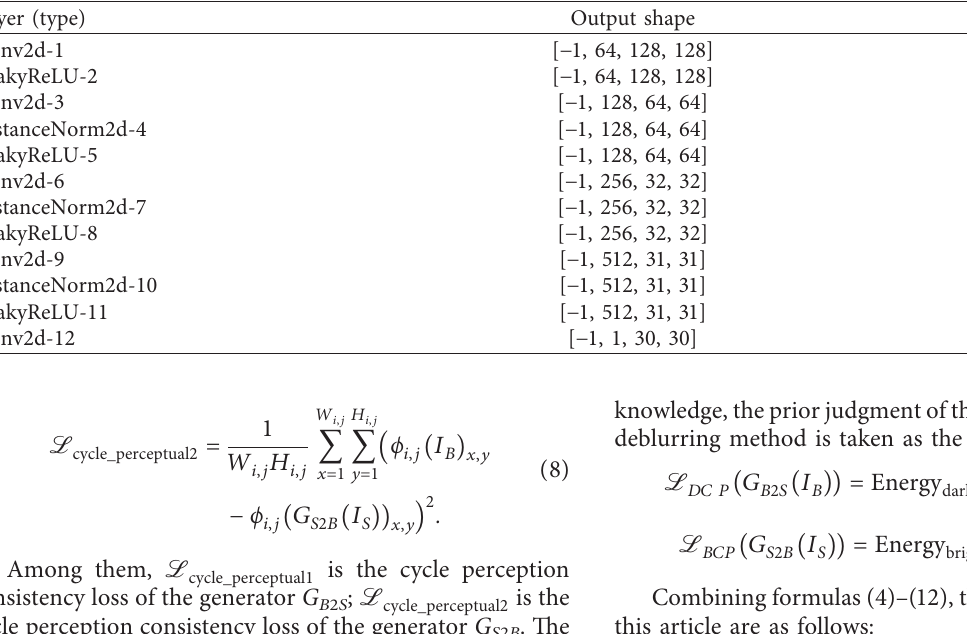
Table 2: The layer structure and parameters of the